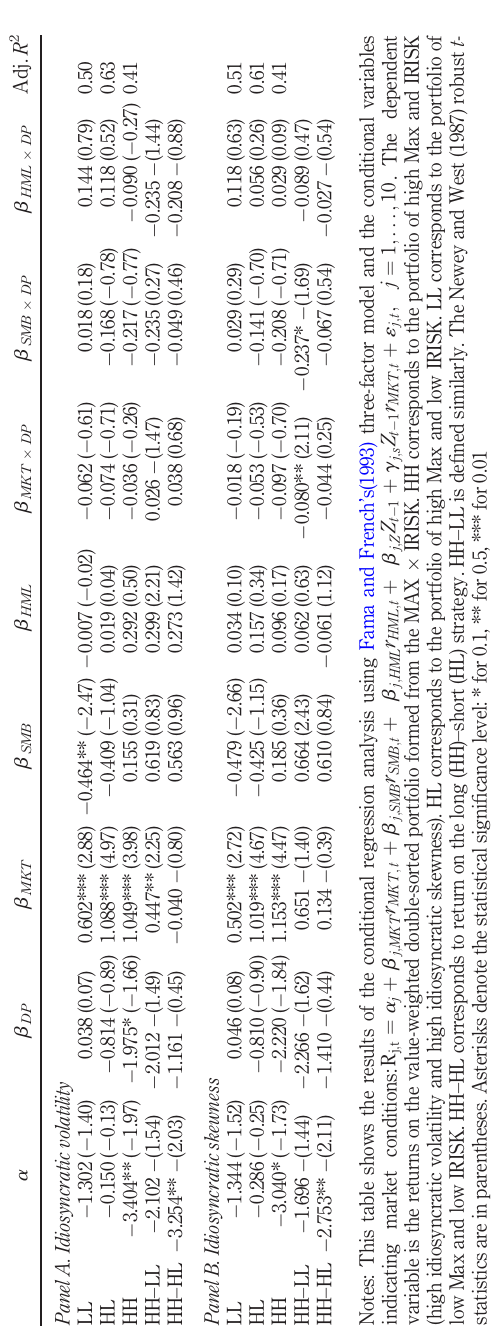
Table 11. Conditional regressions with market ’ s dividend yield: MAX and